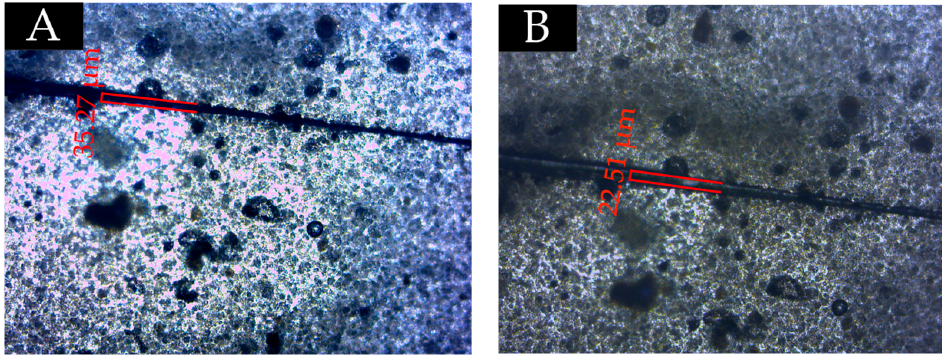
Figure 16. Scratch width of the coating with microcapsules: ( A ) scratch image and ( B ) scratch image after 48 h.